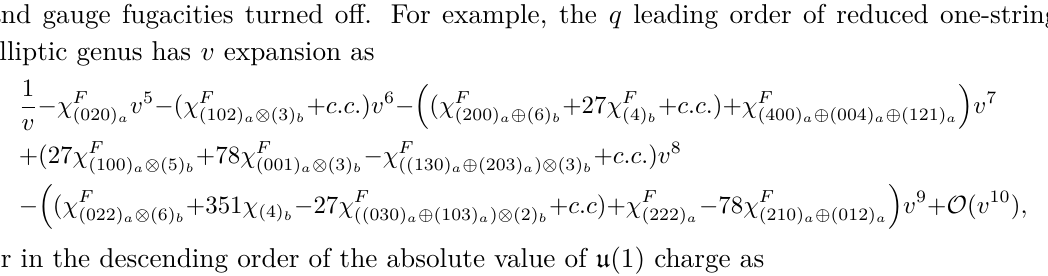
We also computed the elliptic genus with all flavor su (4) and gauge fugacities turned off. For example, the q leading order of reduced